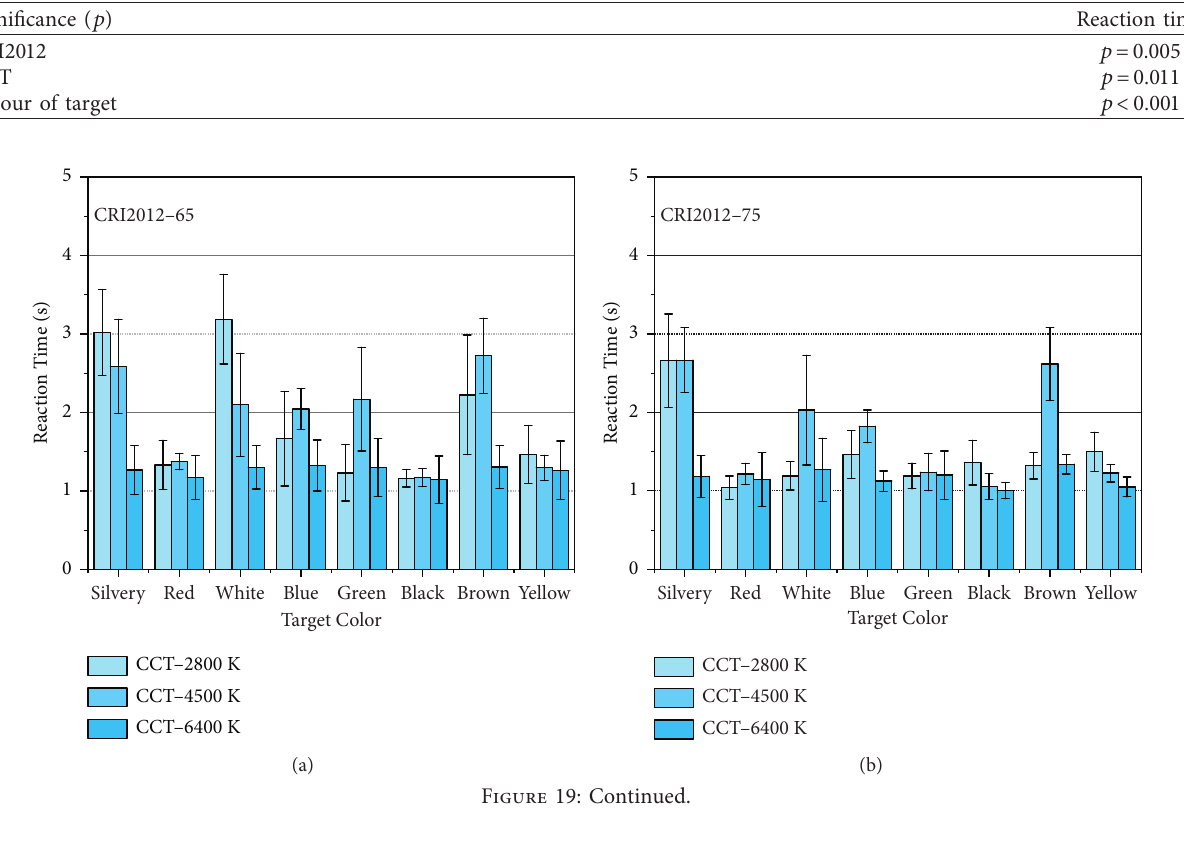
Table 2: Correlation analysis of all experimental data.